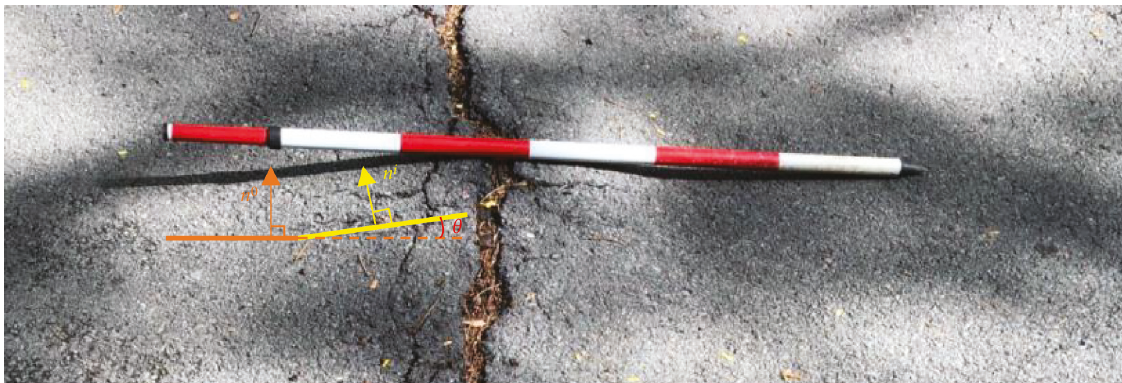
Figure 8: Normal vector at the crack and its neighbor